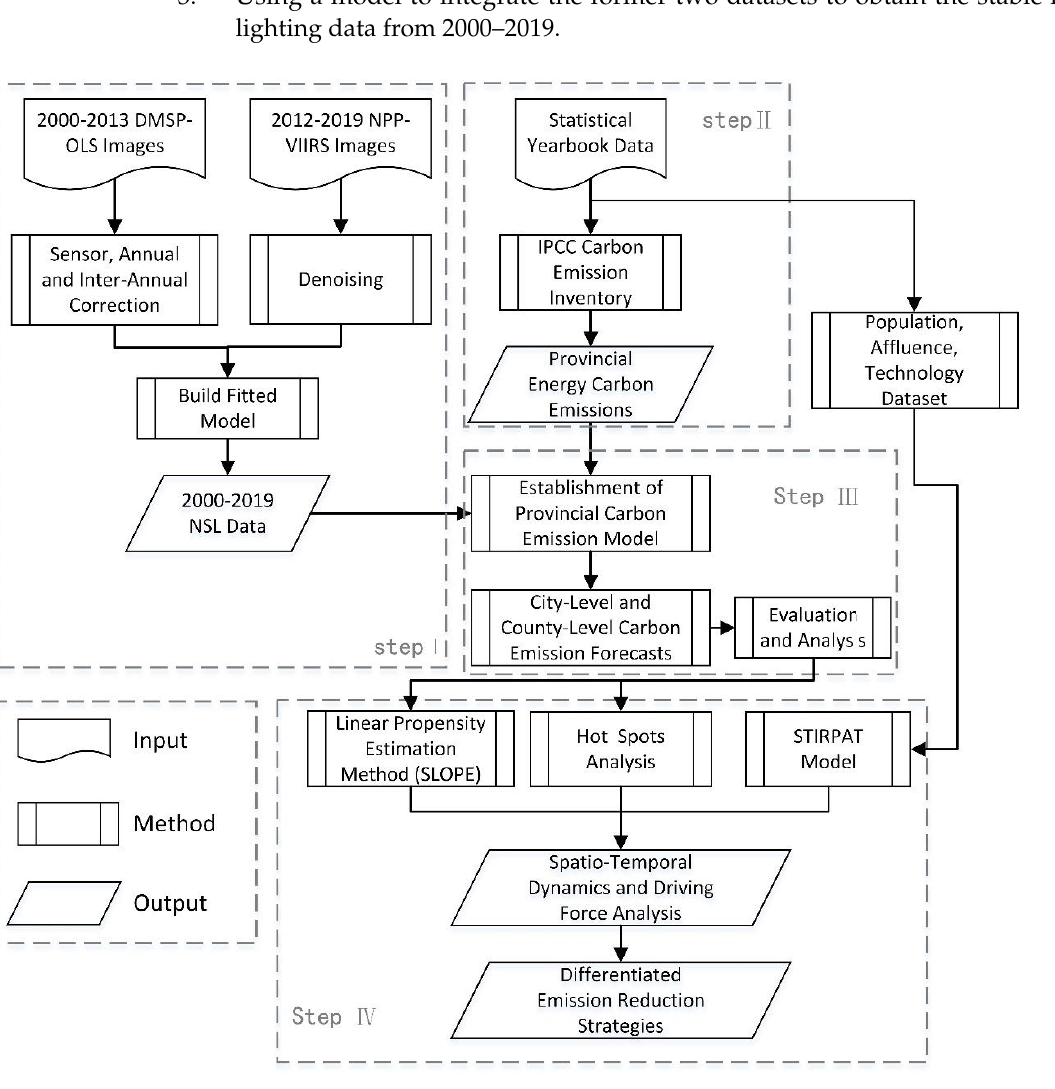
Figure 2. Flowchart of Beijing – Tianjin – Hebei carbon emission technology. Because NPP-VIIRS are the monthly average data and are polluted by stray light, the light data from May to July in the middle and high latitude areas of summer in China are seriously distorted, and the pixel value is 0. Therefore, the missing months were elimi- nated and the other months were synthesized to obtain the annual comprehensive data. The images and DMSP-OLS images were then resampled to 1 km × 1 km and projected onto the Albers equal area projection. The invariant region method was selected to carry out sensor correction, annual correction and inter-annual correction for DMSP-OLS data, and then the continuity was improved. For the specific method, we referred to the study of Elvidge [18]. After viewing the distribution of the data, it was found that approximately 99% of the pixel values were low (DN < 0.3). In order to remove the weak light in the NPP- VIIRS data (usually regarded as noise), the threshold method was used to correct it, and 0.3 10 −9 W cm −2 sr −1 was used as the empirical threshold, while values less than 0.3 in the NPP-VIIRS data was assigned as 0 [32]. Because there were abnormally high light val- ues in NPP-VIIRS images, the method of Zhao [33] was adopted in this paper. The pixel values higher than those of China ’ s three megacities (Beijing, Shanghai and Guangzhou) (DN MAX ) in other regions were considered as outliers caused by oil, gas or fire. Each outlier was iterated to the maximum value in its respective 3 × 3 neighborhood raster DN until no value exceeded DN MAX . Because of the dispersion of the two groups of data, it is difficult to fit the data di- rectly, so the coefficient of variation ( cv ) method was used to deal with this problem [34].